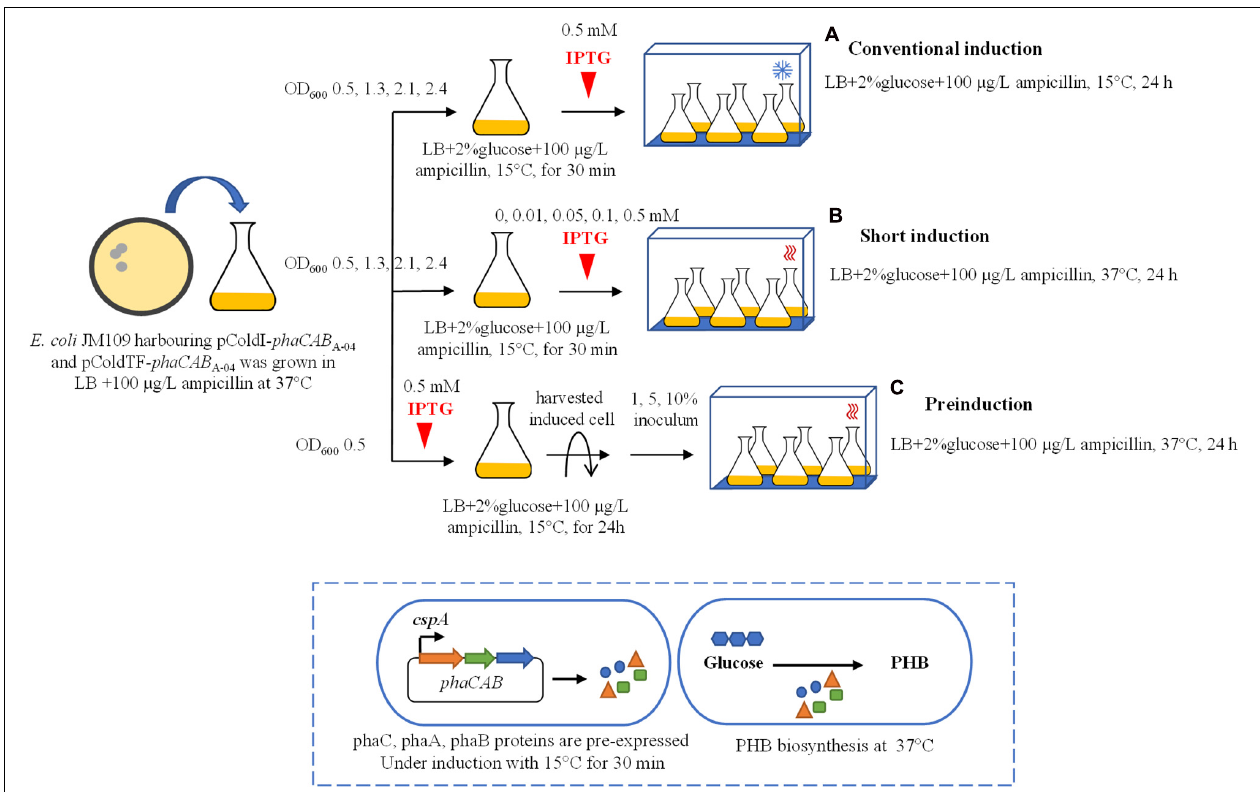
FIGURE 1 | Schematic of three different induction methods for heterologous expression of the phaCAB A - 04 biosynthesis operon in E. coli JM109 (pColdI- phaCAB A - 04 ) and E. coli JM109 (pColdTF- phaCAB A - 04 ). (A) Conventional induction method: the culture was incubated at 37 ◦ C and 200 rpm until the OD 600 reached 0.5, 1.3, 2.1, and 2.4. Then, the cultivation temperature was decreased from 37 to 15 ◦ C for 30 min, and the expression of the phaCAB A - 04 operon was induced by the addition of 0.5 mM IPTG. The cultivation temperature was further maintained at 15 ◦ C for 24 h. (B) Short-induction method: the culture was incubated at 37 ◦ C and 200 rpm until the OD 600 reached 0.5, 1.3, 2.1, and 2.4. Then, the temperatures were varied at 15, 25, 30, and 37 ◦ C for 30 min. Next, the expression of the phaCAB A - 04 operon was induced by adding various concentrations (0.01, 0.05, 0.1, 0.5, and 1.0 mM) of IPTG, and the cultivation temperature was maintained at 37 ◦ C for 24 h. (C) Preinduction method: the culture was incubated at 37 ◦ C and 200 rpm until the OD 600 reached 0.5. Next, 0.5 mM IPTG was added into the culture when the temperature was decreased from 37 ◦ C to 15 ◦ C for 24 h. Then, the induced cells were harvested by centrifugation, the medium was discarded, and the cells were resuspended in an equal volume of fresh LB medium. Finally, the induced cells at 1, 5, or 10% (v/v) were transferred into fresh LB medium supplemented with 100 µ g/L ampicillin and 20 g/L glucose and incubated at 37 ◦ C and 200 rpm for 24